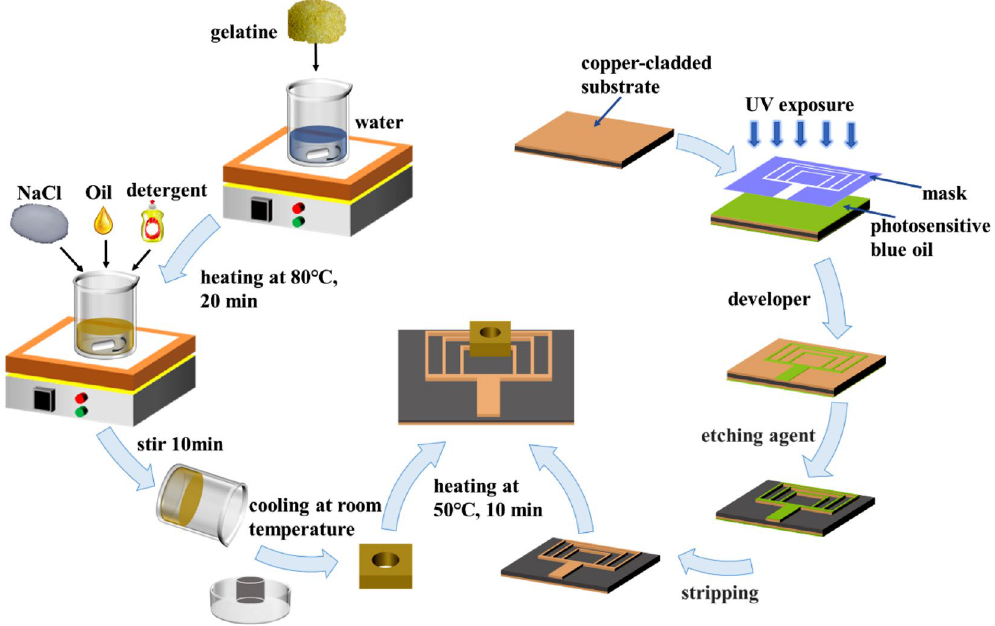
Figure 8. Illustration of the processes involved in the microfluidic sensor